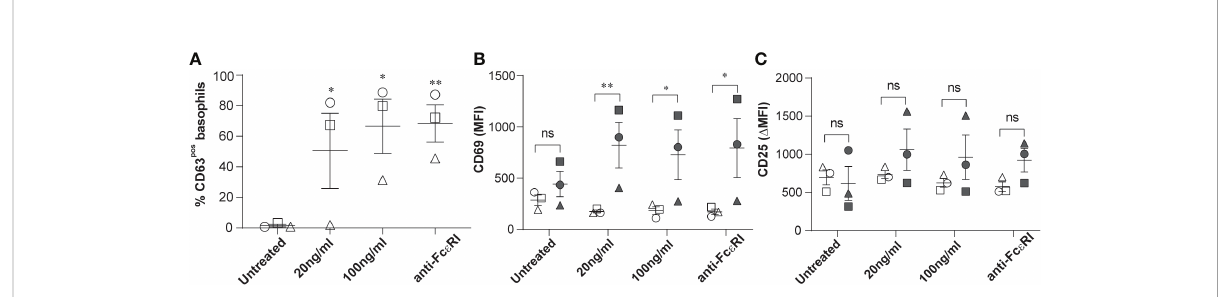
FIGURE 2 Effects of ex vivo allergen challenge on CD63, CD69, and CD25 expression in activated and non-activated basophils. Whole blood samples from stable-mildly symptomatic allergic asthma patients (n=3) were stimulated with their respective allergen (20ng/ml or 100 ng/ml) or anti-Fc e RI cross- linking antibody 29C6 (100 ng/ml). Unstimulated controls were exposed to stimulation buffer only. (A) Percentage of CD63 pos basophils in unstimulated controls, 20 ng/ml, and 100 ng/ml allergen and anti-Fc e RI cross-linking antibody stimulated samples. (B, C) MFI of CD69 (B) and D MFI (MFI of test-MFI of FMO control) of CD25 (C) are shown on CD63 neg (open symbols) and CD63 pos basophils (closed symbols). (A-C) Patients 1, 2, and 3 are represented as circle, square, and triangle symbols, respectively. Data are shown as mean ± SEM and analyzed using one-way ordinary ANOVA tests, with Dunnett`s (A) or Bonferroni`s (B, C) multiple group comparison test. **P<0.01 and *P<0.05. ns, not signi fi